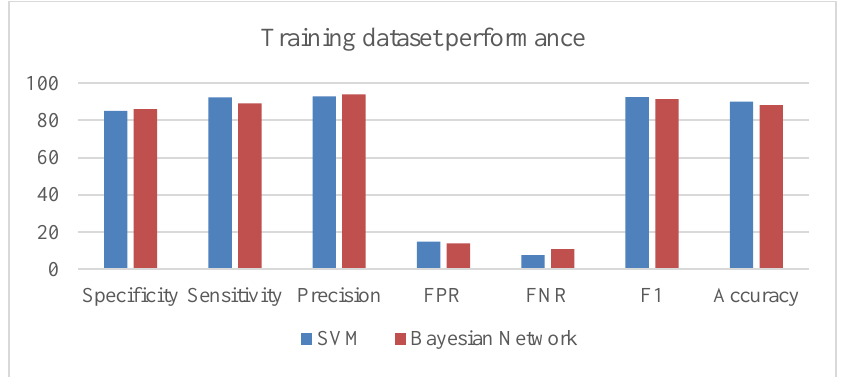
Figure 2. Performance of SVM and Bayesian networks in training dataset.